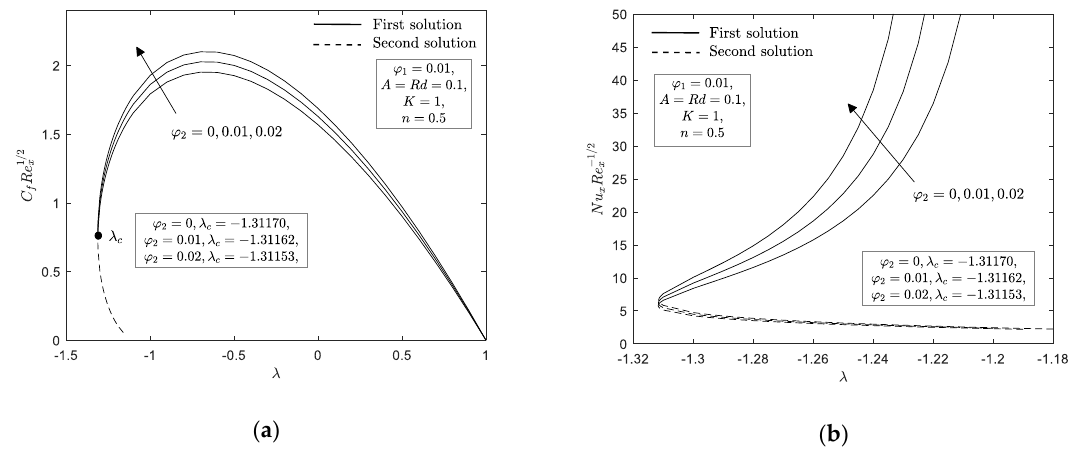
− 1/2 Nu  with  for various x with λ for various ϕ 2 . x x